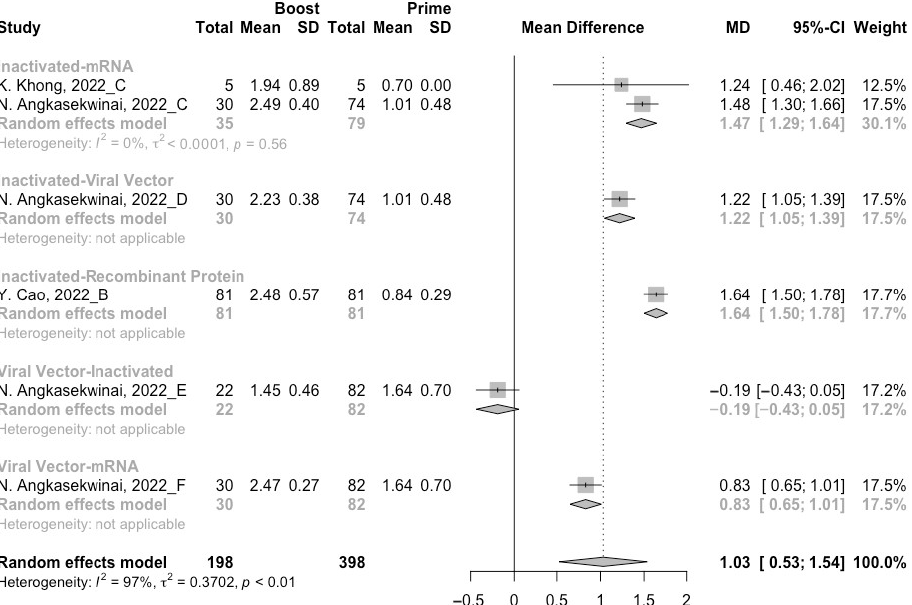
Figure 10. Forest plot of the pooled log-transformed neutralization titers against the Beta variant before and after heterologous booster vaccination.